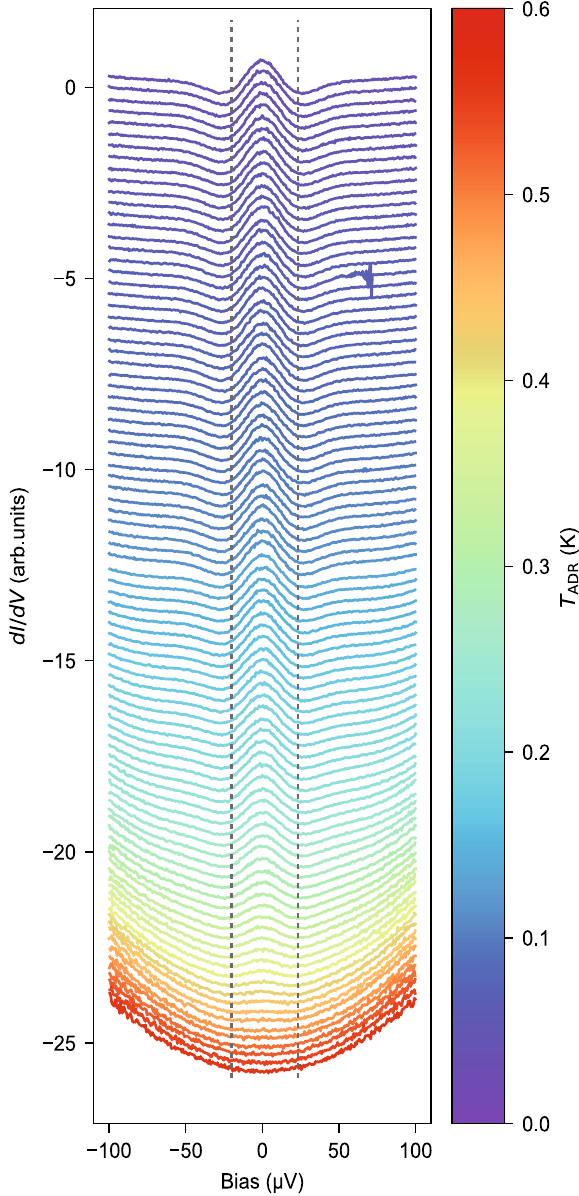
Fig. 3 Dependence of the differential conductance d I /d V of the Josephson junction on the cryostat temperature T ADR . Higher- temperature data are shifted downwards for clarity. The dotted lines are guides to the eye, highlighting the temperature dependence of the Josephson conductance